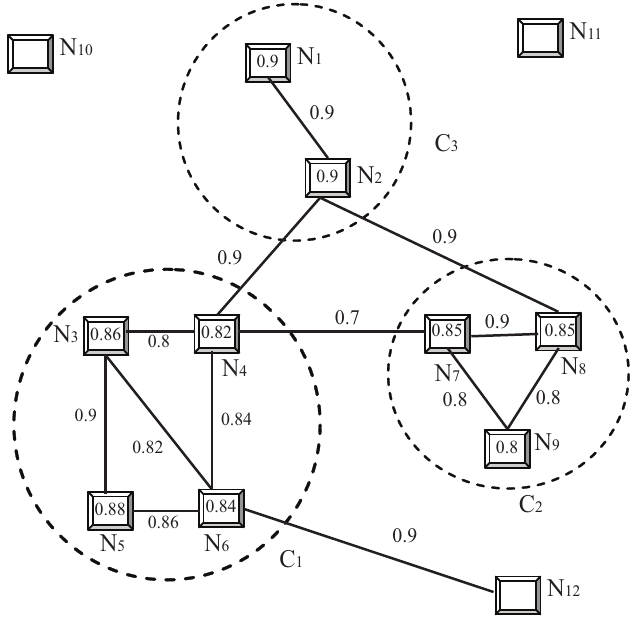
Figure 1. A network with three communities. A community detection strategy is fed with a network structure as well as node and edge attributes. The network structure identifies the relationships between the nodes; specifically, the related nodes are linked and the weights over the links (edges) show the strength or importance of a connection. The attributes include the information for nodes, like profession, age, and groups of interest that one can find in a Facebook or Instagram profile. Sometimes, signs are also used to indicate positive or negative